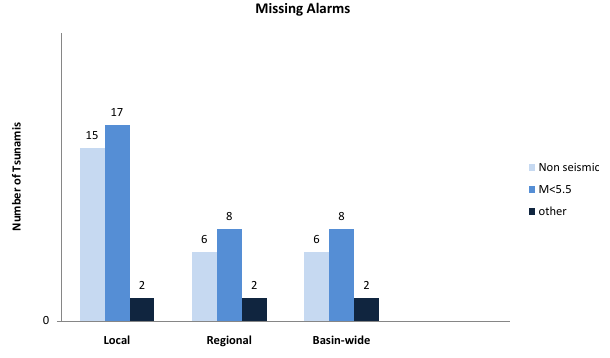
Fig. 4. Missing alarms distinct by causes and by distance